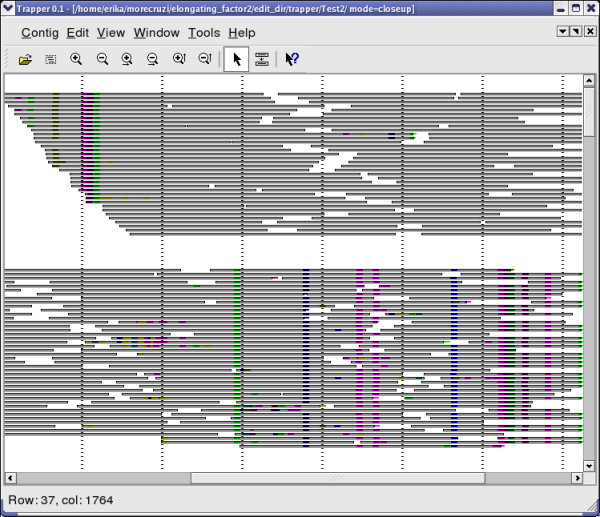
EF2 assembly after division into two groups according to DNP content. Mate pair analysis of the two groups confirmed the two groups are located on different homologs.